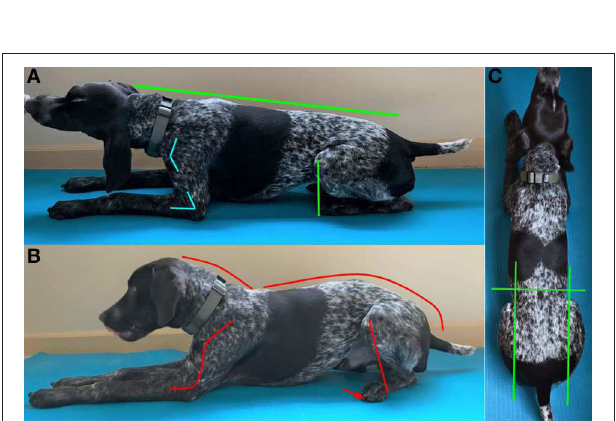
FIGURE 3 | (A) Shows the Posture Down in the correct position. Note the straight line from the head to the base of the tail. The forelimb is flexed at the elbow and shoulder. The stifle is dorsal to or just cranial to the digits. (B) Shows the Posture Down in the incorrect position. Note the extended elbow and rounded spine (cervical, thoracic, and lumbosacral). The hindlimbs are abducted and the stifle is caudal to the digits. The red arrow indicates the abduction of the hind foot. (C) Shows the correct position of the Posture Down from above (the dorsal view) the dog. All four ipsilateral limbs are aligned in a sagittal plane, and the hindlimb digits are obscured by the stifles.